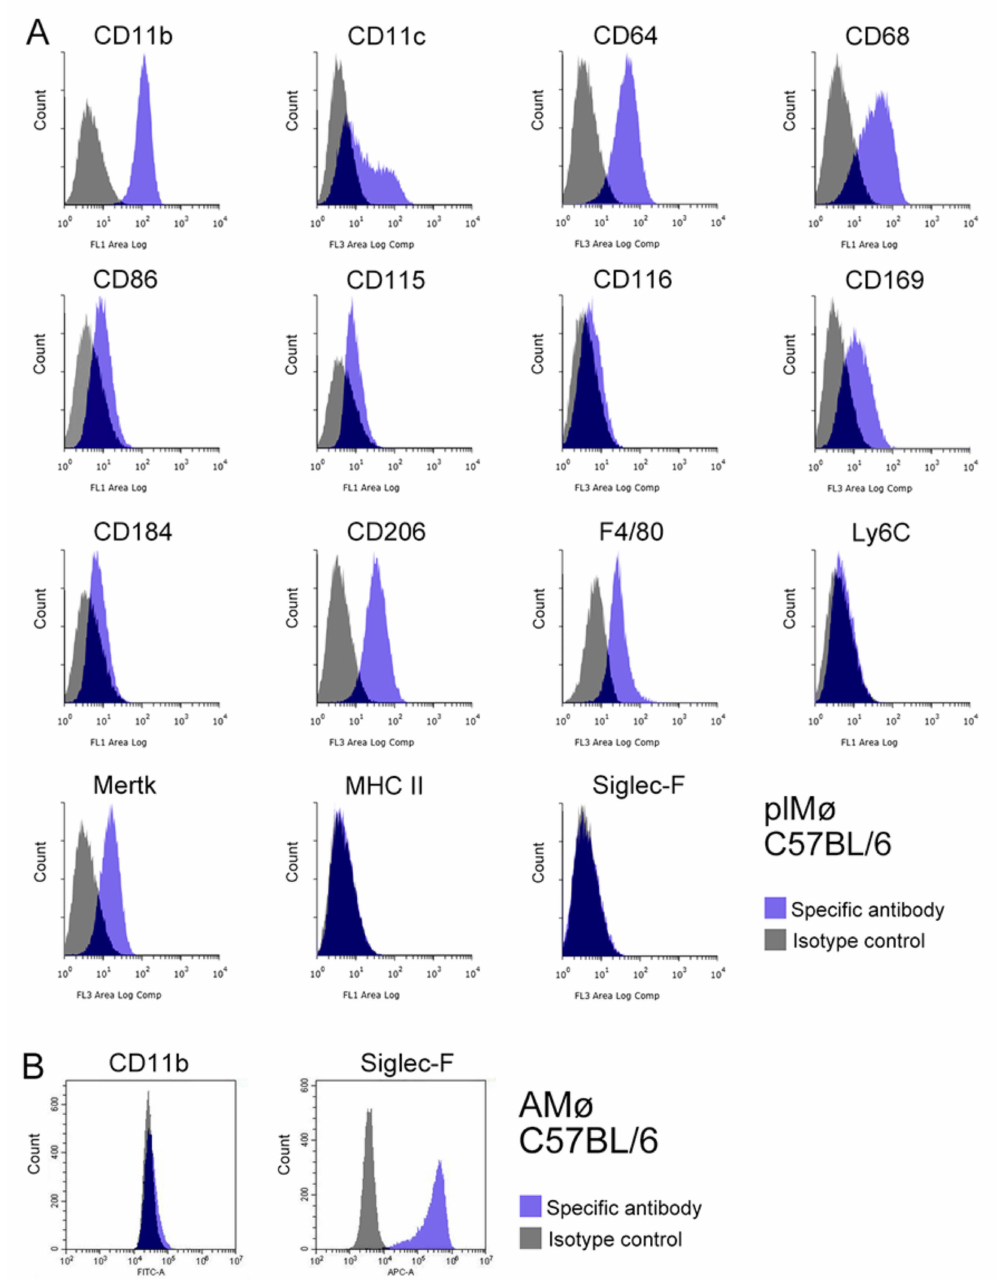
Figure 5. Representative histograms from flow cytometric analyses showing the expression of 15 Mø/monocyte markers in propagated lung tissue-resident Mø by co-culturing as well as CD11b and Siglec-F expression in alveolar Mø from C57BL/6/c mice. ( A ): The expression patterns of CD11b, CD11c, CD64, CD68, CD86, CD115, CD116, CD169, CD184, CD206, F4/80, Ly6C, Mertk, MHC II and Siglec-F in propagated lung tissue-resident Mø (plMø) in co-culture and by subculture (blue histogram, specific antibody; grey histogram, isotype control). plMø shows the characteristic expression patterns of Mø/monocyte marker membrane proteins, such as the high expressions of CD11b, CD64 and CD206; substantial/clear expressions of Mertk, CD115 and CD169; as well as no/almost no expressions of CD116, Ly6C, MHC II and Siglec-F. The low/faint and high expression fractions are present in CD11c. ( B ): CD11b and Siglec-F expression in alveolar Mø (AMø) from C57BL/6